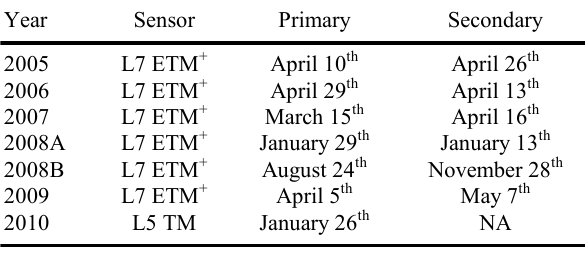
Table 1. Sensor and dates of Landsat images per year.